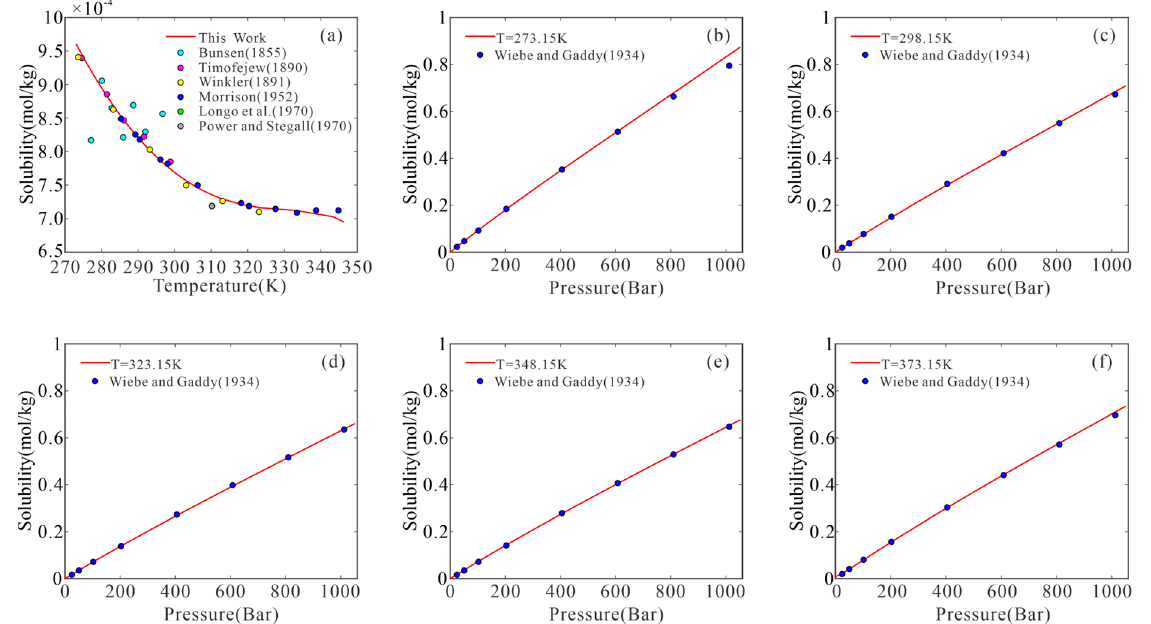
Figure 2. H 2 solubility versus pressure in pure water: model predictions (red lines) and experi ‐ mental data (colored circles). (( a ) The point reported by Bunsen [19], Timofejew [40], Winkler [42] Morrison [44], Longo et al. [48] and Power and Stegall [49]; ( b – f ) The point reported by Wiebe and Gaddy [20]; All the curves calculated using the proposed model).